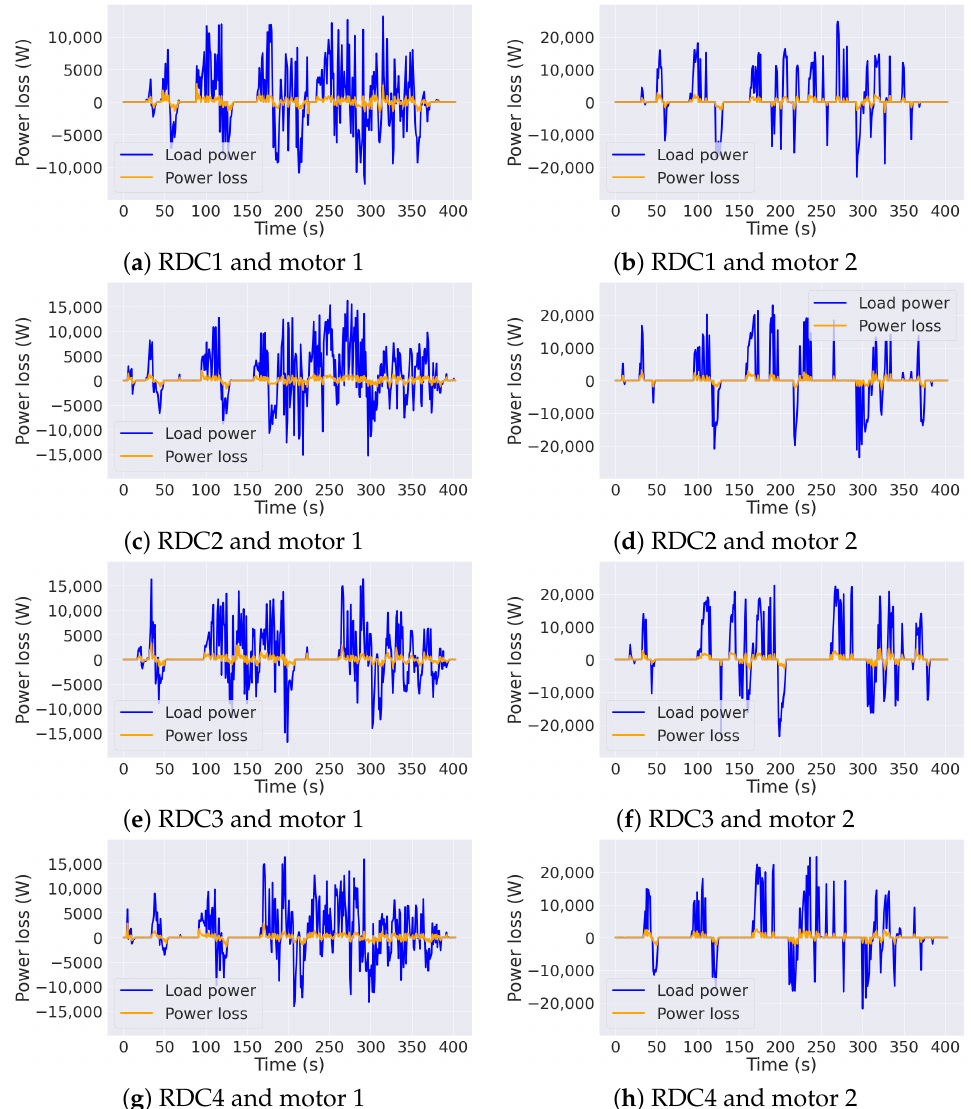
Figure 5. Load power and losses for the two motors and the four RDCs: ( a ) load power and loss for motor 1 and RDC1; ( b ) load power and loss for motor 2 and RDC1; ( c ) load power and loss for motor 1 and RDC2; ( d ) load power and loss for motor 2 and RDC2; ( e ) load power and loss for motor 1 and RDC3; ( f ) load power and loss for motor 1 and RDC3; ( g ) load power and loss for motor 1 and RDC4; ( h ) load power and loss for motor 2 and